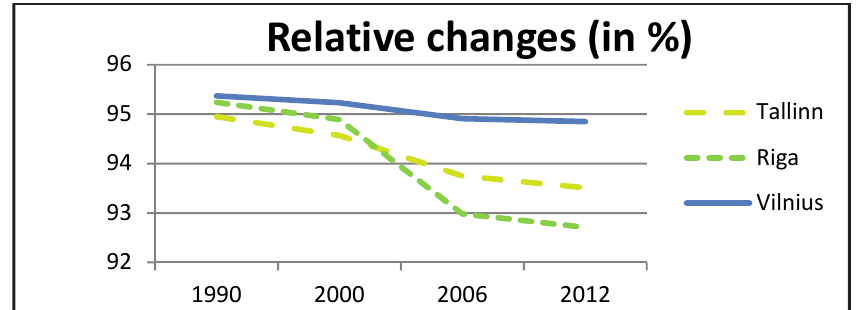
Fig. 3. Relative changes of greenery in the FUAs of Tallinn, Riga and Vilnius according to CORINE datasets (data source: